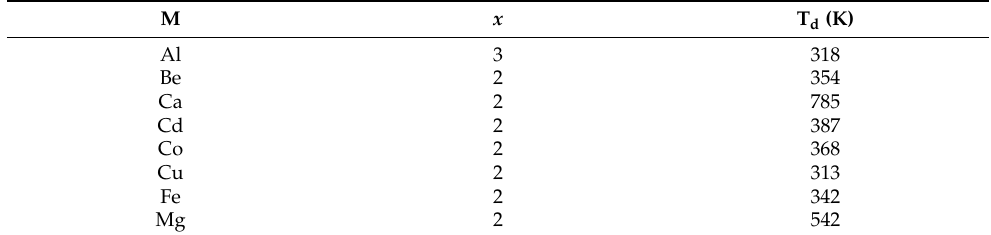
Table 5. The normal decomposition temperatures of some metal hydroxides into metal